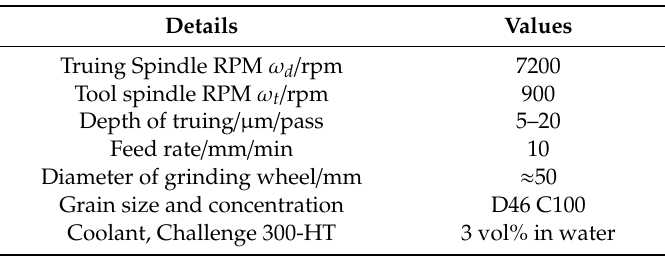
Figure 3. Precision form truing of the spherical diamond wheel. Table 2. Form truing parameters.